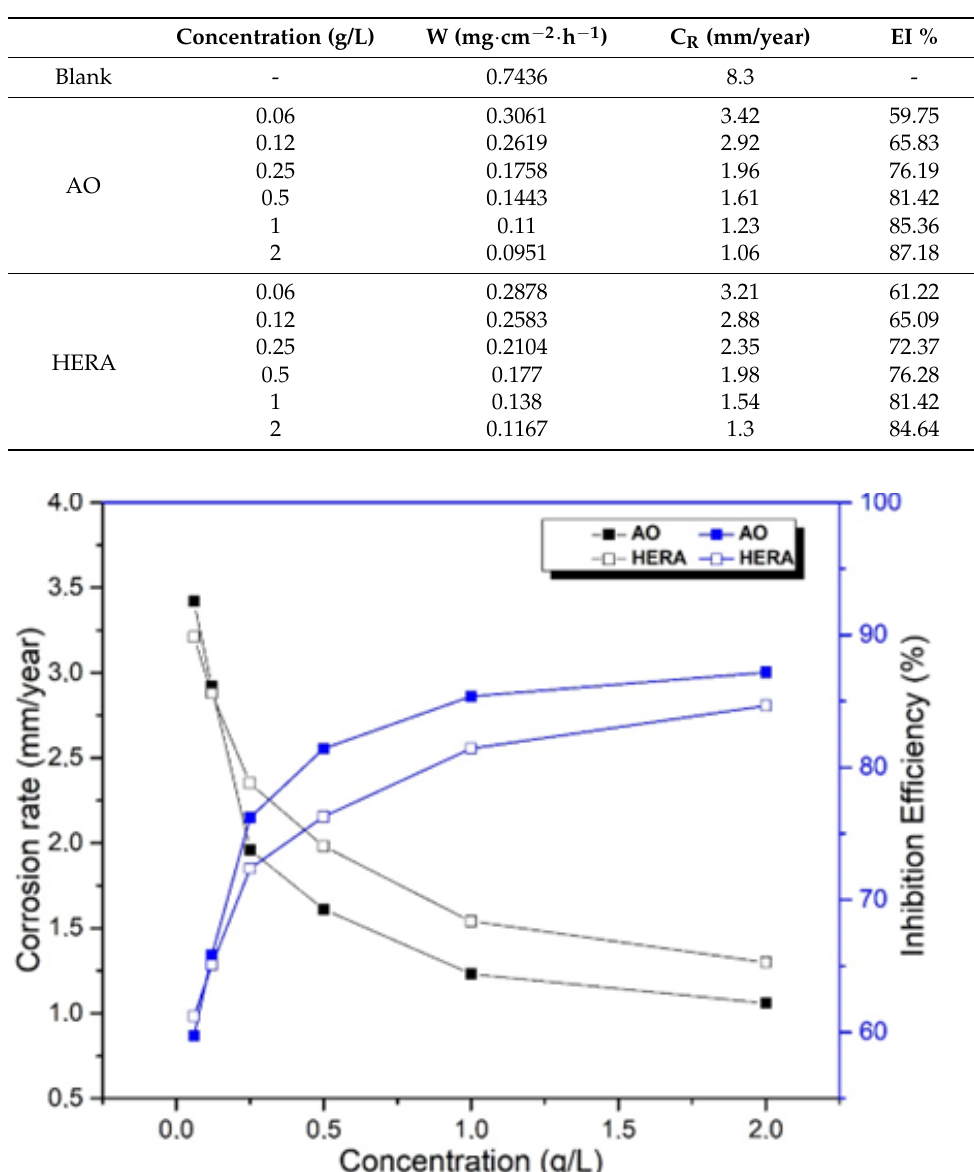
Figure 2. AO and HERA concentration effect on mild steel corrosion rate and corrosion inhibition efficiency.